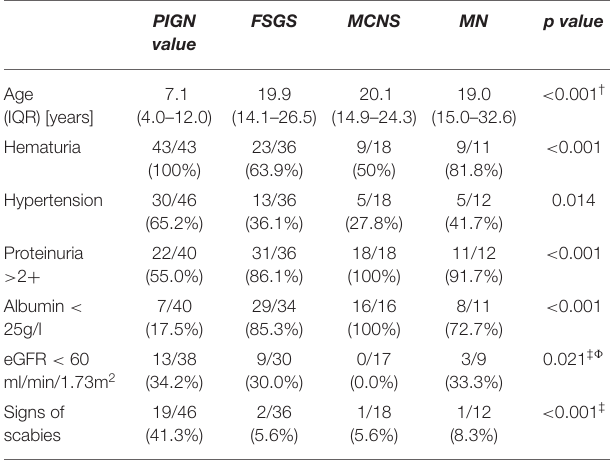
FIGURE 2 | Age distribution of patients with proteinuric kidney disease in The Gambia.